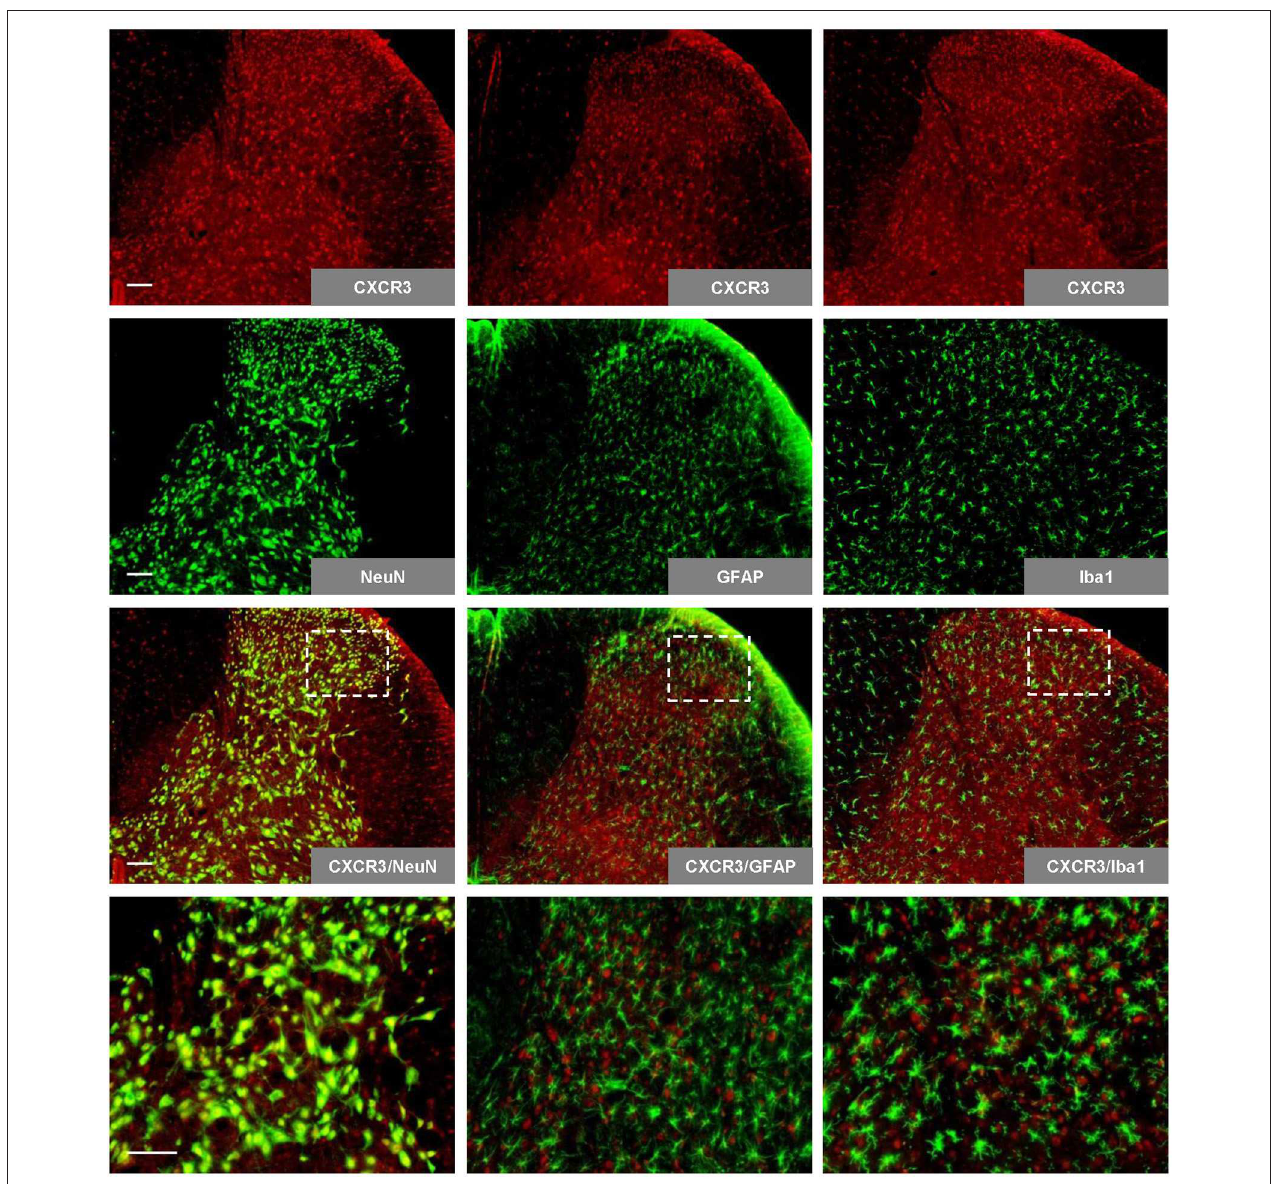
FIGURE 1 | Expression and colocalization of CXCR3 with spinal neuron markers. Spinal CXCR3 is expressed abundantly in the spinal dorsal horn, where it colocalizes with NeuN (neuron marker), but not with GFAP (astrocyte marker) or Iba1 (microglia marker). The last row presents enlargements of the areas in white frames. Scale bar = 100 µ m. NeuN, neuronal nuclear antigen; GFAP, glial fibrillary acidic protein; Iba1, ionized calcium binding adapter